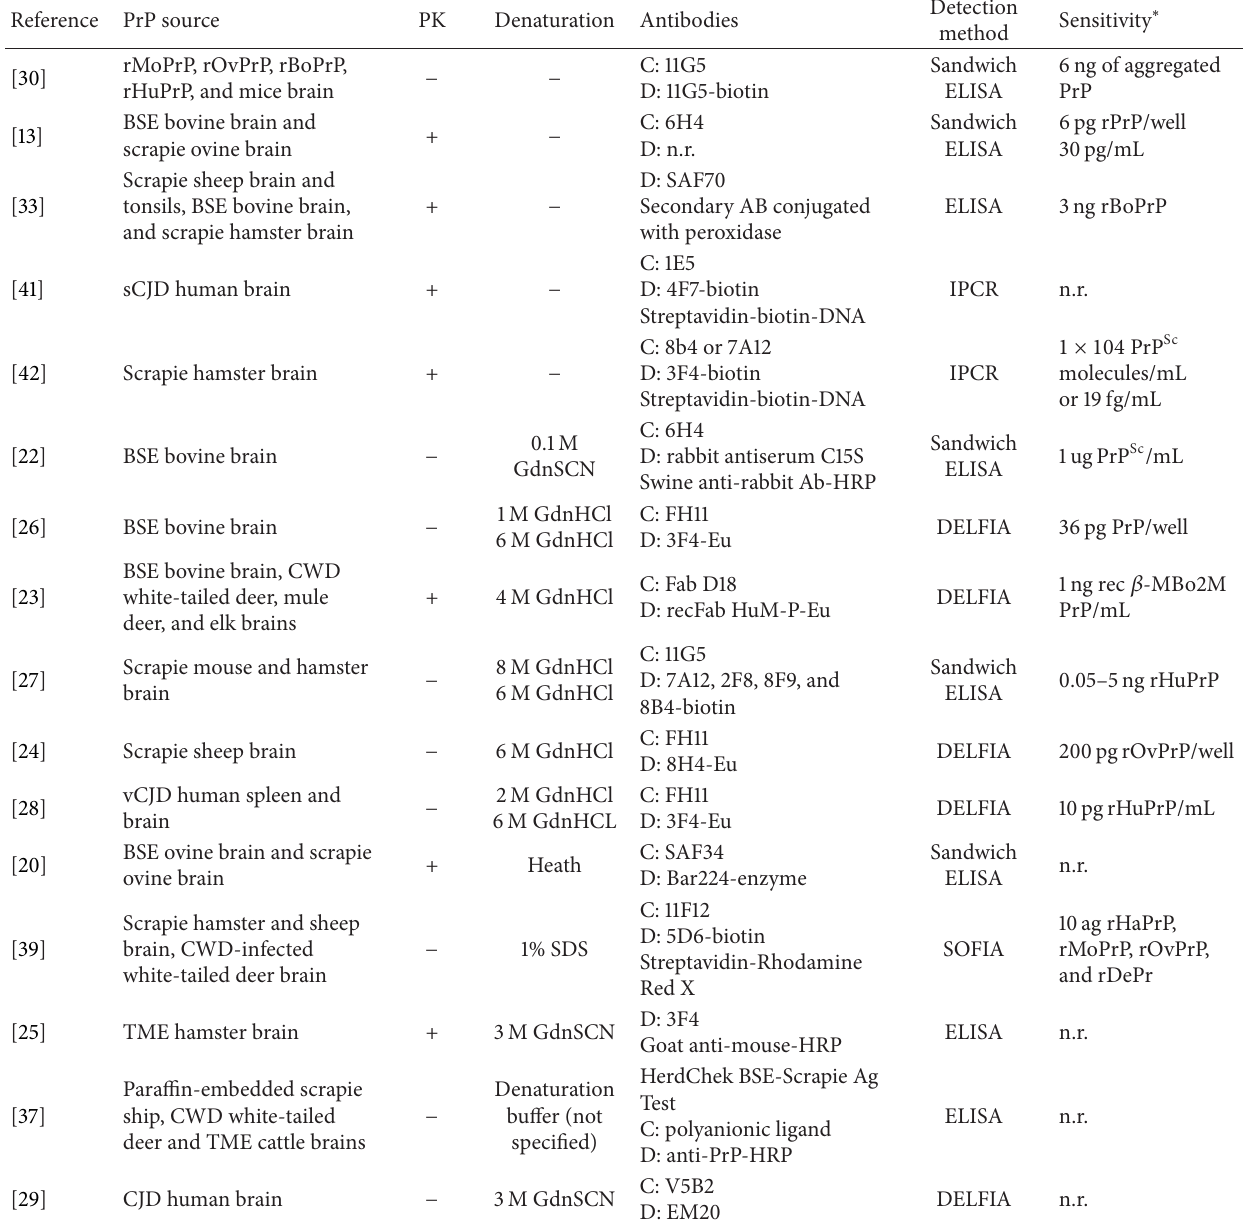
Table 1: Summary of the methods for detection of PrP Sc in brain